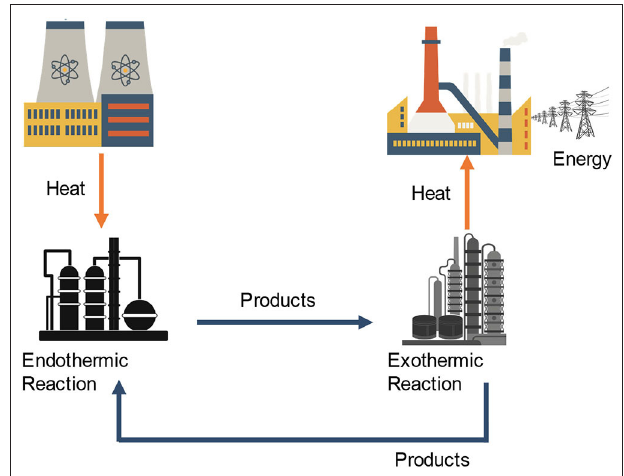
FIGURE 1 | The chemical heat-pipe